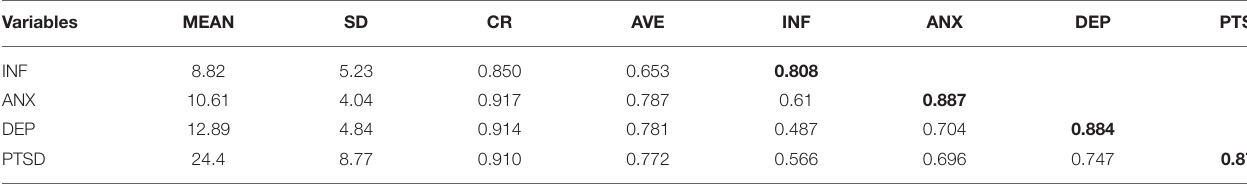
TABLE 3 | Mean, Standard deviation, convergent and discriminant validity.